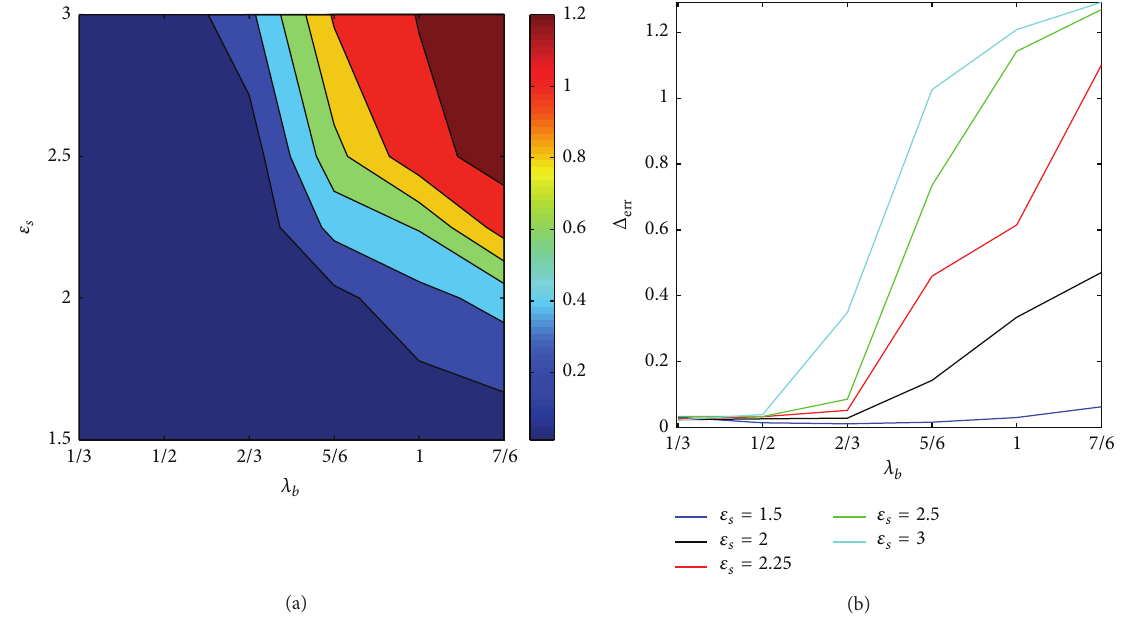
Figure 2: Validation analysis: (a) plot of Δ err for the parameters’ values reported in Table 1 and (b) cut of Δ err for different values of 𝜀 𝑠 .